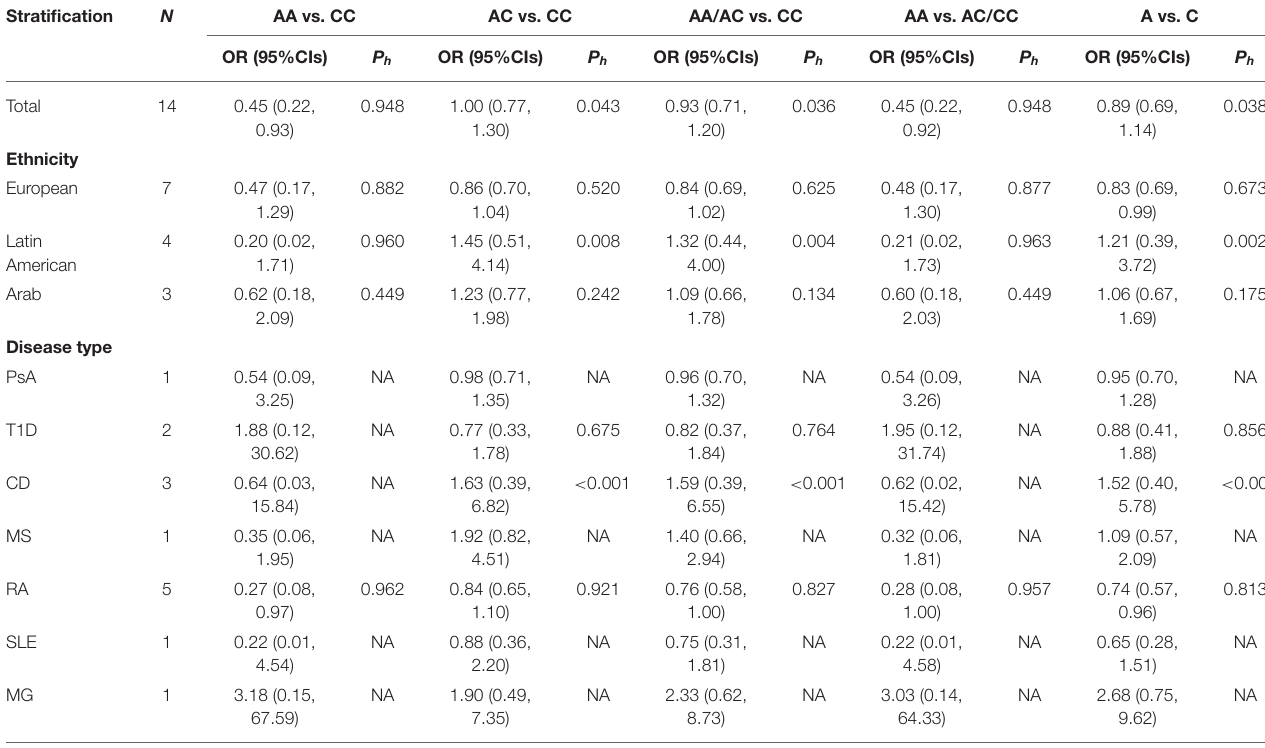
TABLE 3 | Summary of odd ratios (OR) and 95% CIs of NLRP3 rs35829419 polymorphism and autoimmune diseases (AIDs) susceptibility for various comparisons. Stratification AA vs.